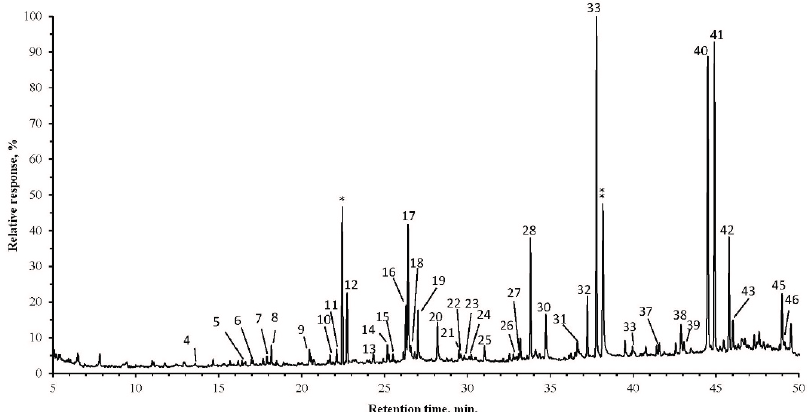
Figure 1. Gas chromatogram with mass-spectrometric detection of the total lipid extract of Polytrichum commune (PC). IS, internal standard (* methylheptadecanoic acid, ** progesterone); numbers refer to the compounds listed in Table 1. Acid and alcohol groups were derivatized prior to the GC/MS